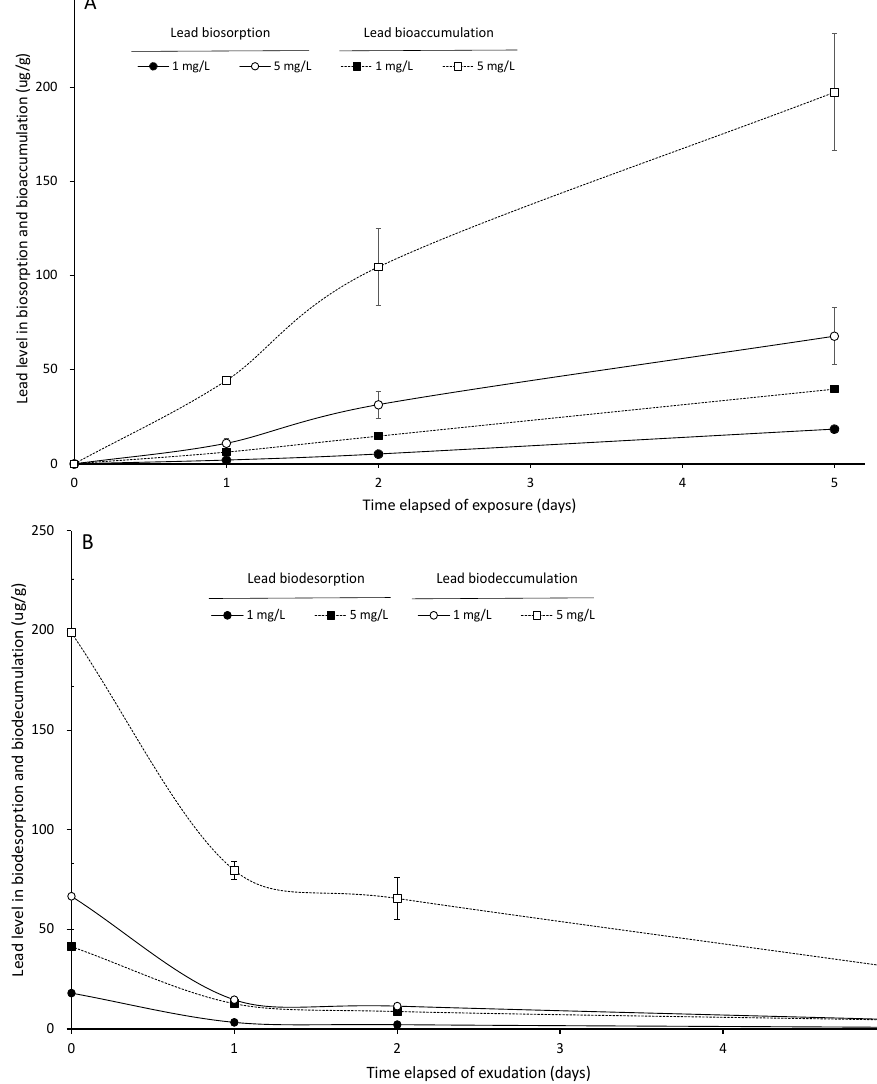
Figure 2. The lead biosorption and bioaccumulation ( µ g/g) of S. suiae exposed to 1 and 5 Pb 2+ mg/L for 1, 2, and 5 days ( A ). The lead biodesorption and biodecumulation of S. suiae exposed to 1 and 5 Pb 2+ mg/L for 1, 2, and 5 days ( B ).